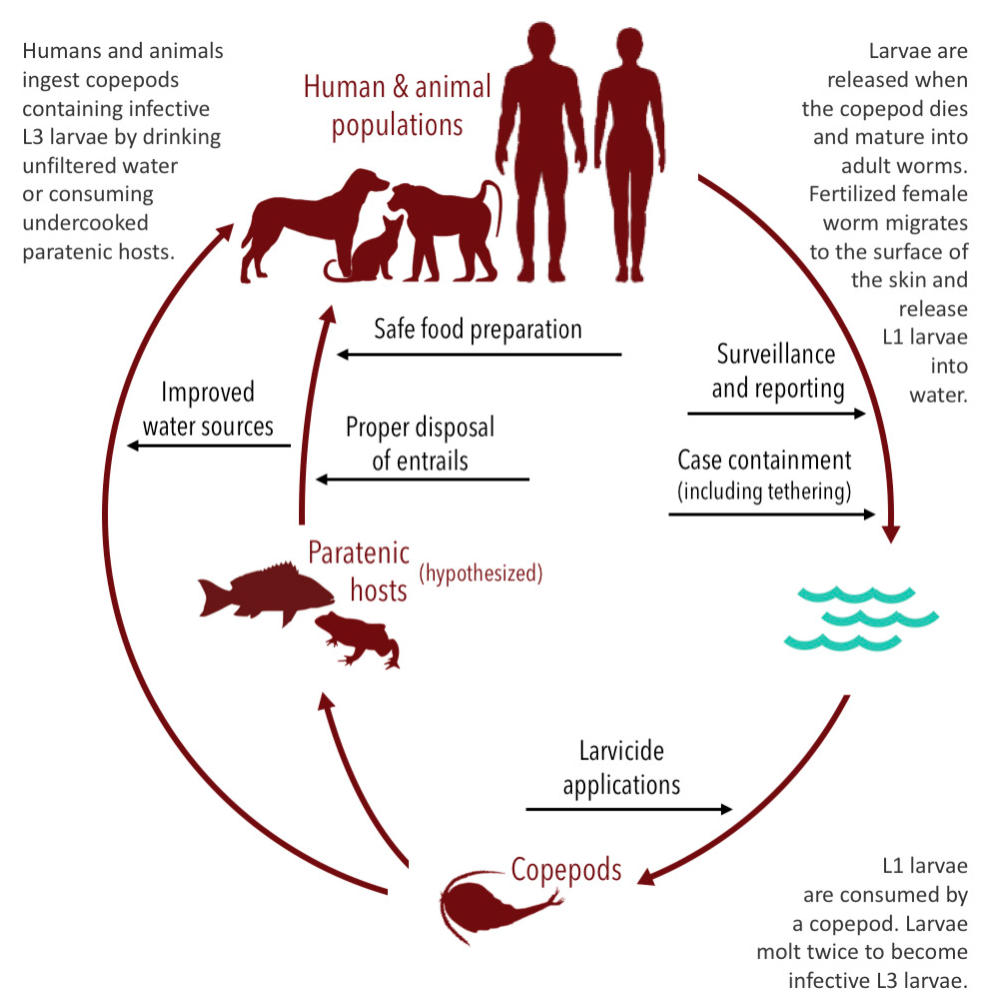
Figure 3. Transmission and life cycle of the Guinea worm with impact points of existing interventions.